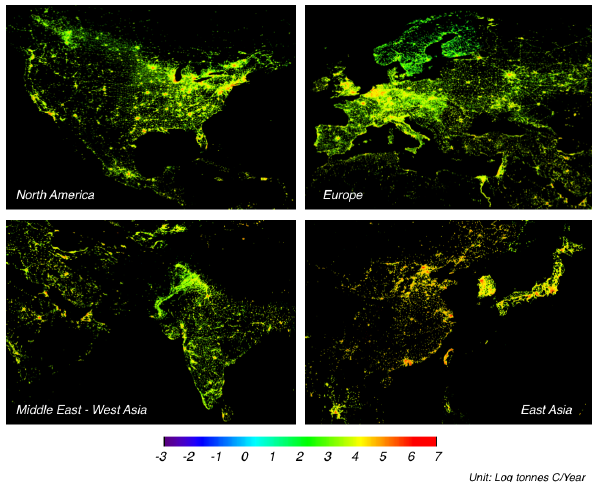
Fig. 6. Regional spatial distributions of CO 2 emissions for the year 2006. From top left (clockwise): North America, Europe, East Asia, and the Middle East and West Asia. The maps shown here were drawn using reduced 5-km-resolution ODIAC inventory on the same scale. Values are given in units of the log (base 10) of tonnes carbon 5 km − 2 year − 1 . Note that the maps are drawn in different scales.